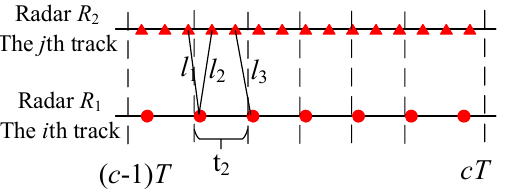
Figure 3. Schematic diagram of asynchronous track of the same